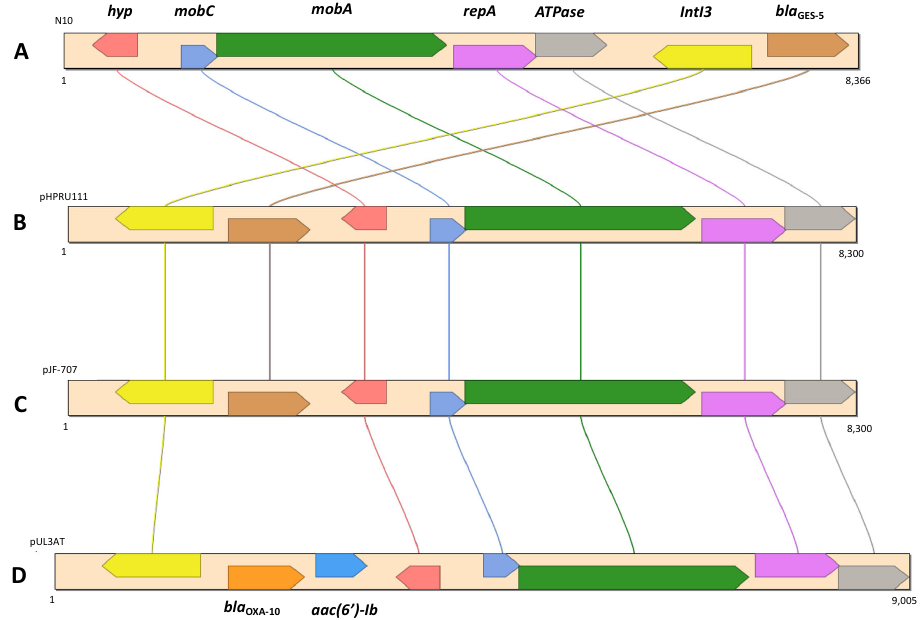
Figure 3. Genetic context of bla GES-5 in E. kobei N10 ( A ), E. cloacae Ecl-W ( B ) (MN180807), K. oxytoca Figure 3 . Genetic context of bla GES ‐ 5 in E. kobei N10 ( A ), E. cloacae Ecl ‐ W ( B ) (MN180807), K. oxytoca strain H143640707 ( C ) (KX946994), and E. cloacae LIM73 ( D ) (HE616889). strain H143640707 ( C ) (KX946994), and E. cloacae LIM73 ( D )